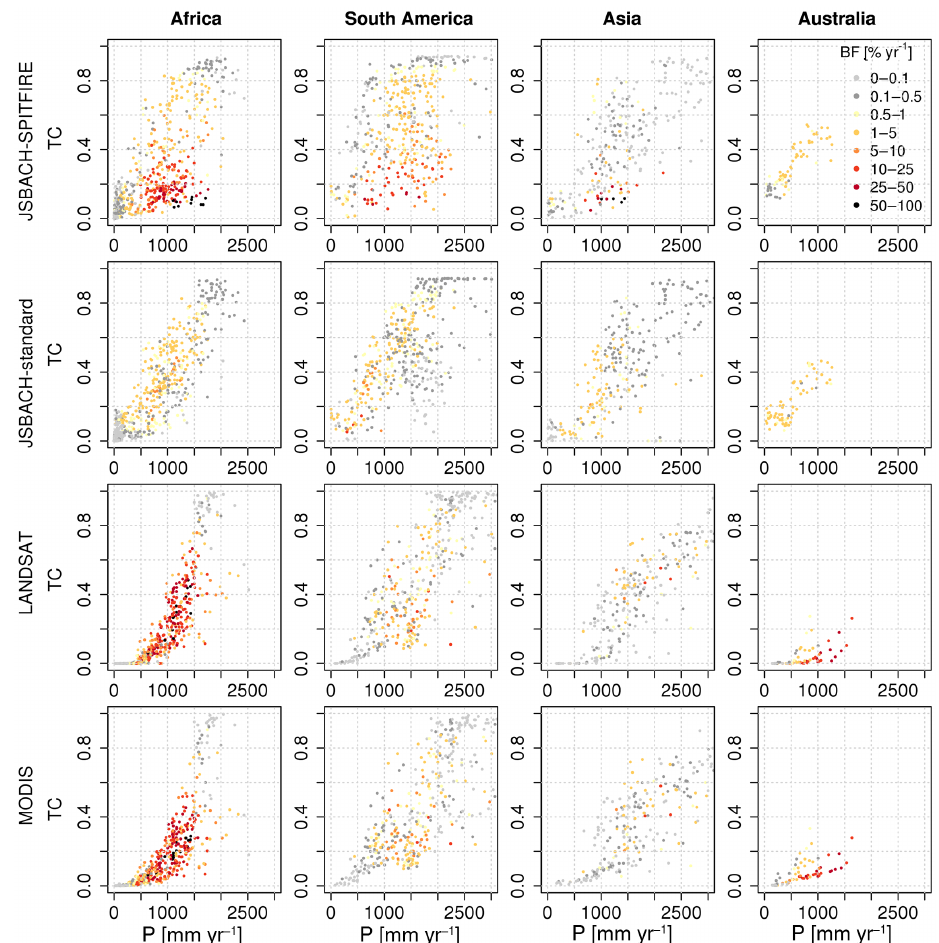
Figure A1. Same as Fig. 4 but tree cover filtered for the presence of shrublands (using the MODIS open and closed shrubland classification). This indicates a low sensitivity of the climate–vegetation–fire relationships to